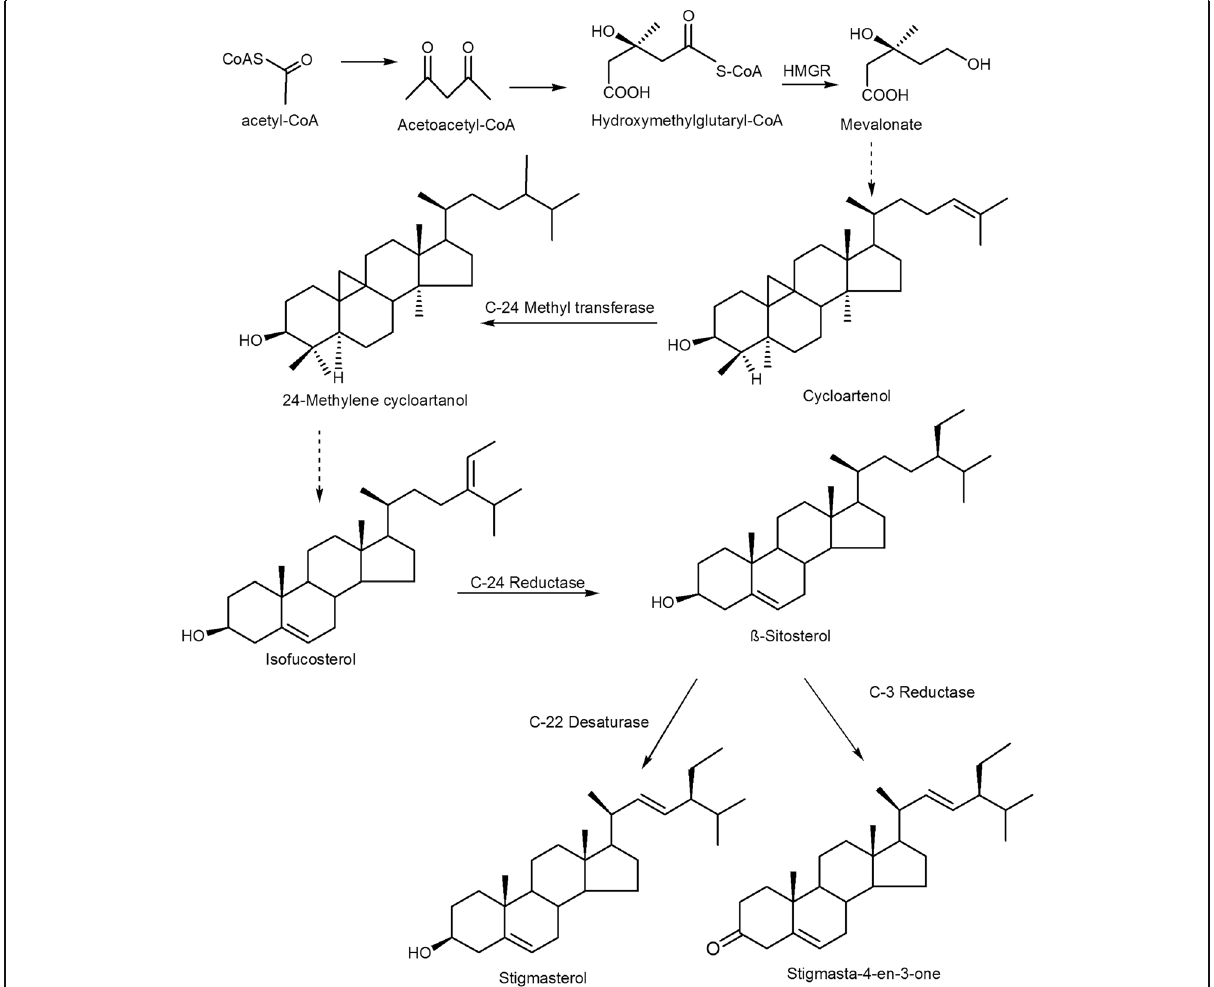
Fig. 4 Schematic representation of the possible biosynthetic pathways for sterols in Thysanolaena maxima